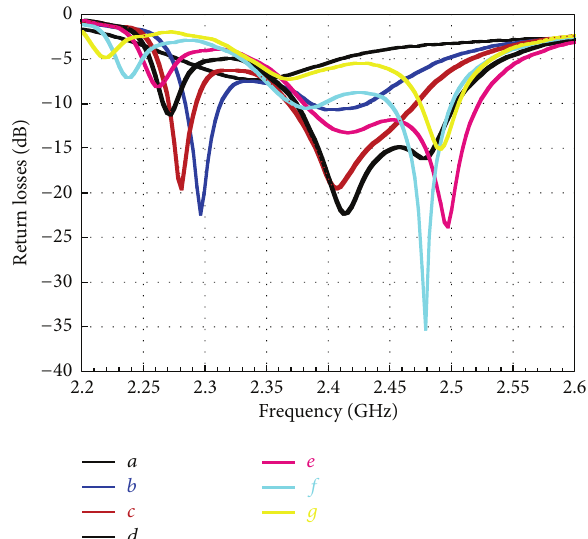
Figure 13: Field pattern for ℎ = 𝜆/9